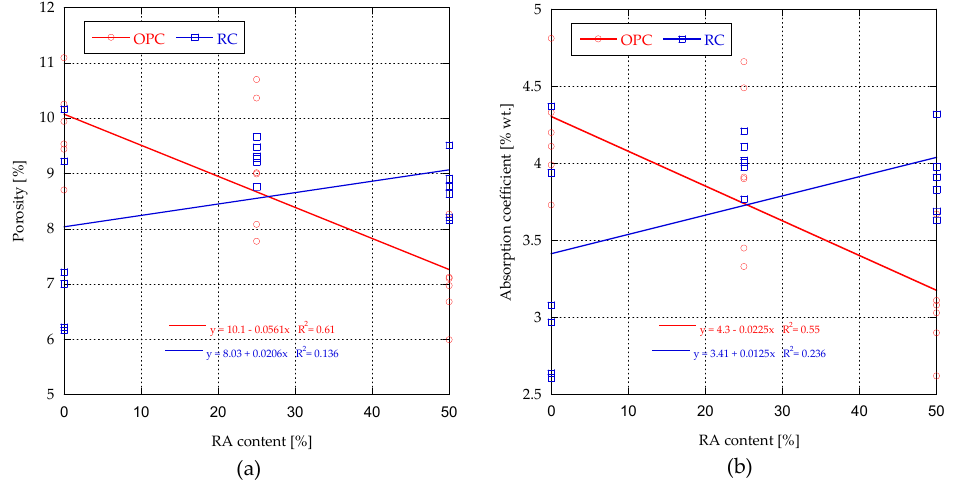
Figure 5. Porosity ( a ) and absorption coe ffi cient ( b ) vs. RA content.